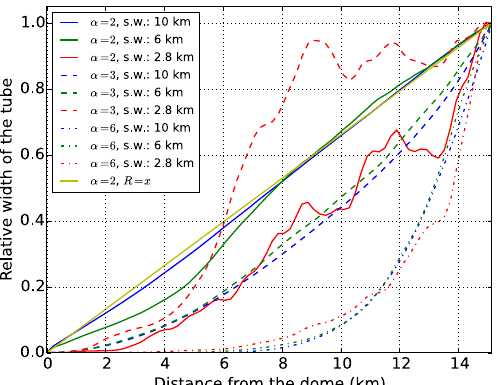
Figure 6. Height of the ice surface (m) for the 2.5-D free surface model, along the ridge. Solid line: circular geometry, α = 2. Dashed line: α = 3. Dotted line: α =